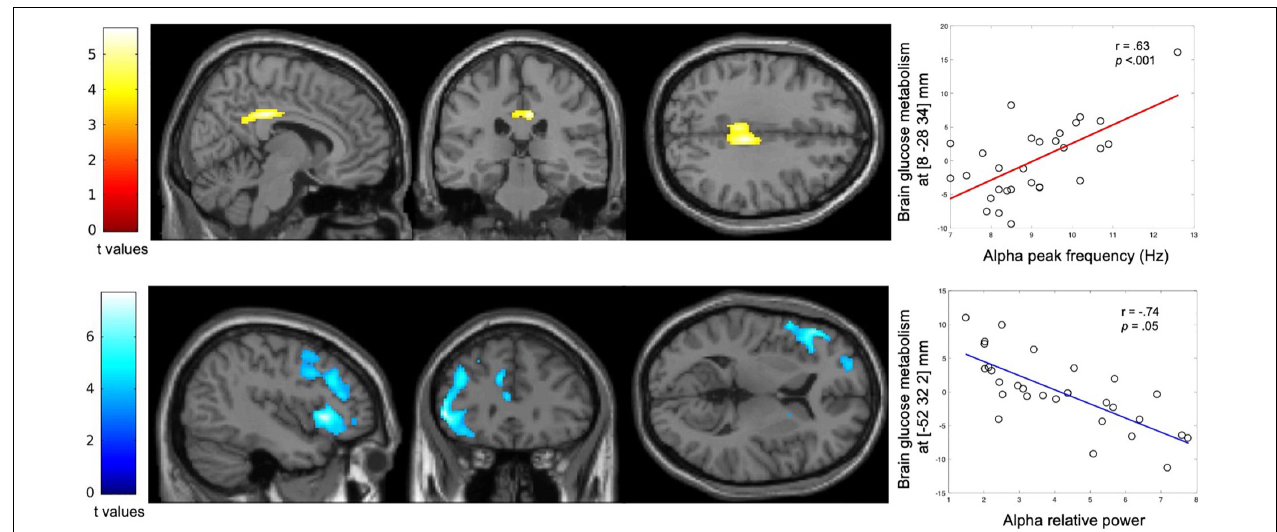
FIGURE 4 | Correlation between spectral parameters of the alpha activity and regional glucose consumption. Statistical parametric T maps evaluating at each voxel the correlation of the FDG-PET data with the APF and alpha relative power derived from MEG data, while controlling for age, gender and years of education. These maps show a significant positive correlation between APF and regional glucose consumption (Top) and a significant negative correlation between alpha relative power and regional glucose consumption (Bottom) across the patients with altered FCSRT performance. Images are thresholded at p < 0.001 uncorrected with a cluster threshold at 100 voxels for visualization purpose. The color scales represent the correlation T-statistic of the significant